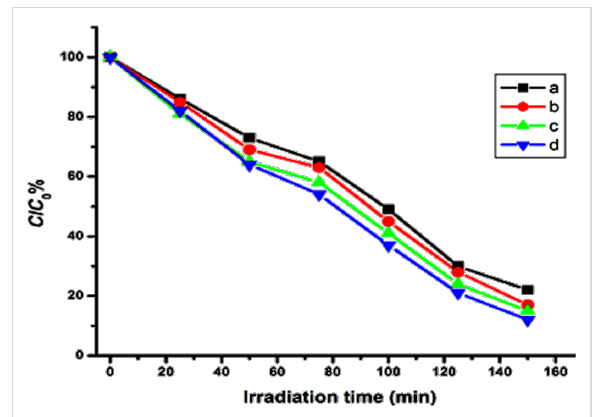
Figure 6: Degradation of RhB by Ta 2 O 5 nanoparticles synthesized from (a) Ta(OEt) 5 , (b) Ta(OEt) 4 (OOCCH 2 Cl), (c) Ta(OEt) 4 (OOCCHCl 2 ) and (d) Ta(OEt) 4 (OOCCCl 3 ).